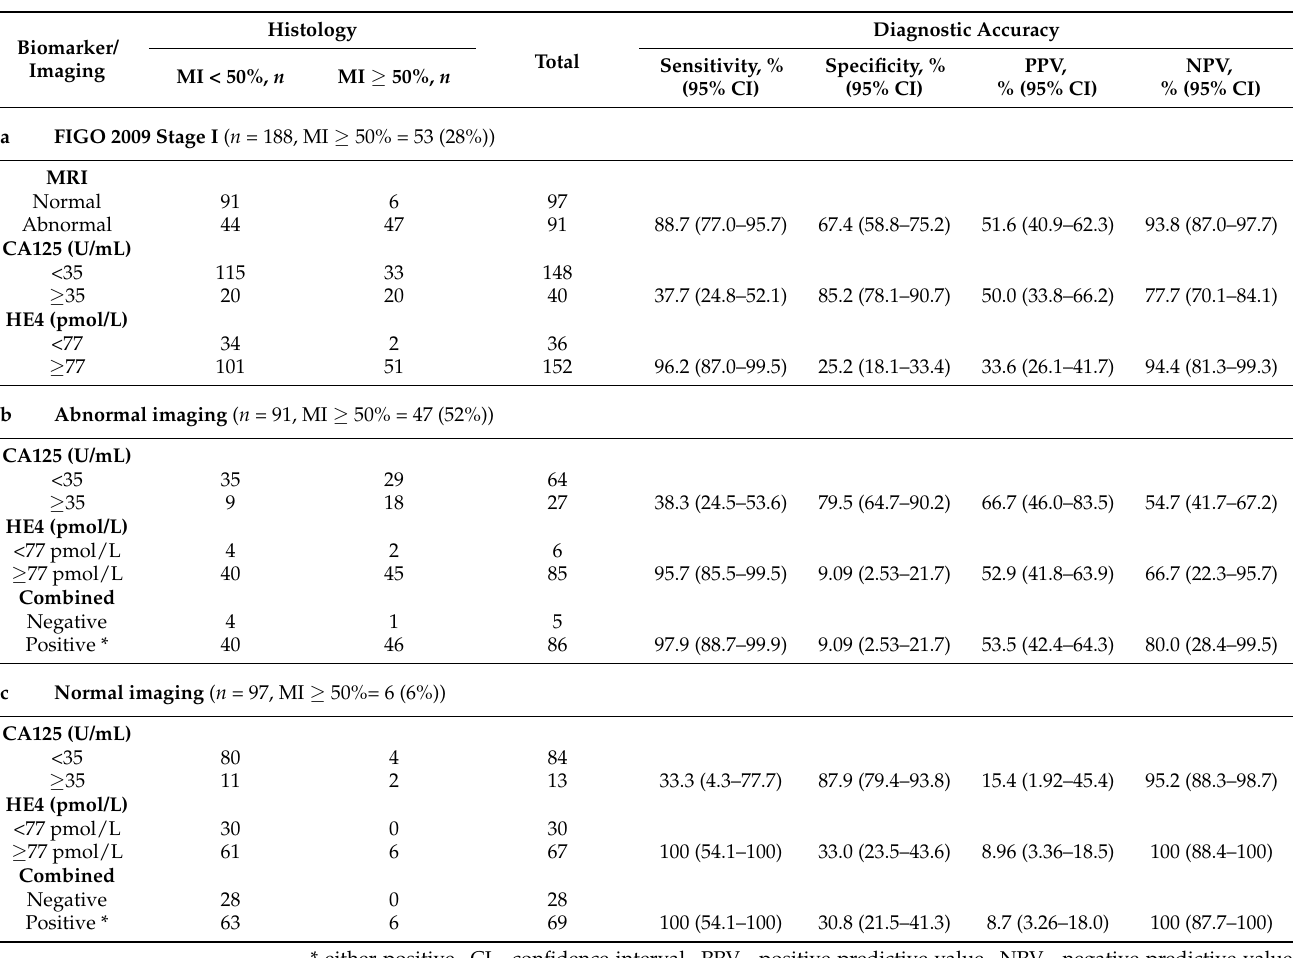
Table 7. Diagnostic accuracy of MRI imaging and serum markers for the detection of MI ≥ 50% in those with FIGO stage I endometrial